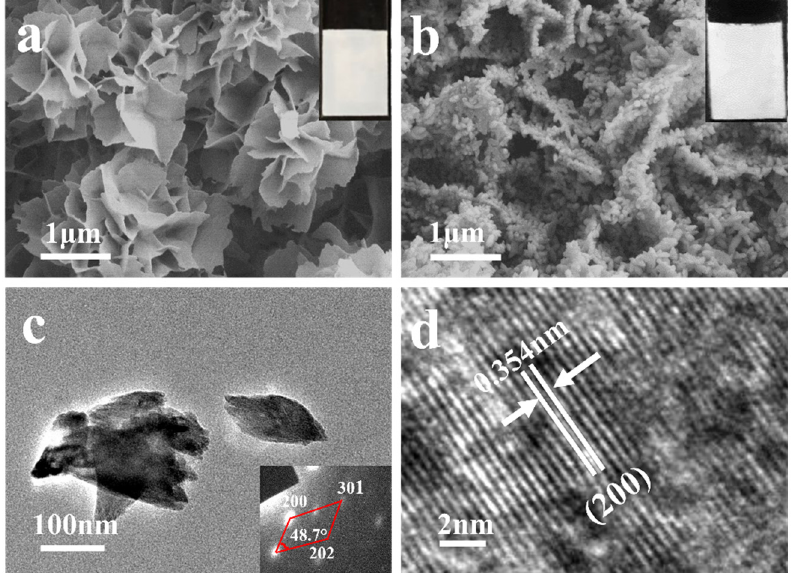
Figure 2. FE-SEM image of the Y 2 (OH) 5 NO 3 ·nH 2 O film ( a ), FE-SEM image ( b ), TEM image ( c ), and HR-TEM image ( d ) of the YVO 4 film. The inset in ( a ) is the digital photograph of the Y 2 (OH) 5 NO 3 ·nH 2 O film, The inset in ( b ) is the digital photograph of the YVO 4 film and the inset in ( c ) is the selected area electron.